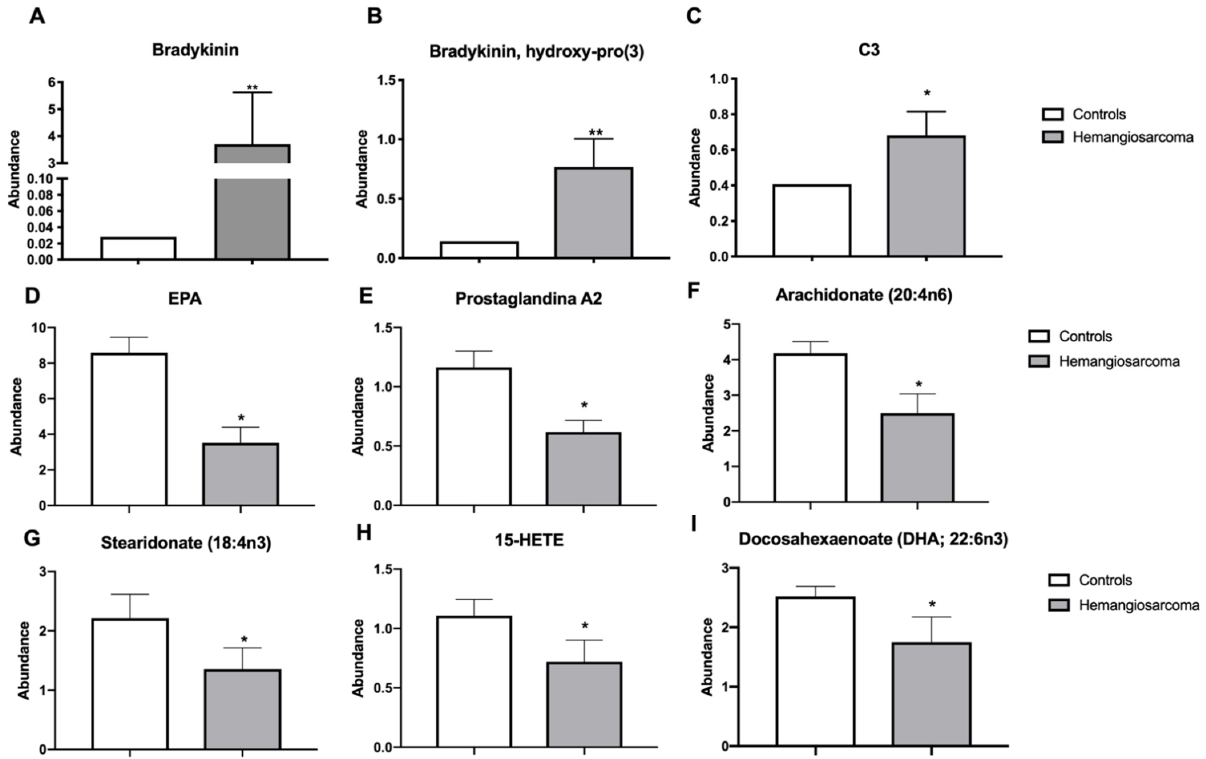
Figure 2. Serum inflammatory proteins bradykinin and C3 are elevated while anti-inflammatory lipids are diminished in VC-mediated hemangiosarcoma. Serum bradykinin ( A ), hydroxylated bradykinin ( B ), C3 ( C ), EPA ( D ), prostaglandin A2 ( E ), arachidonate (20:4n6) ( F ), stearidonate (18:4n3) ( G ), 15-HETE ( H ) and DHA (22:6n3) ( I ) are plotted for Control and Hemangiosarcoma groups. Data are represented as mean ± SEM. * denotes significance with p < 0.05, ** p < 0.01.